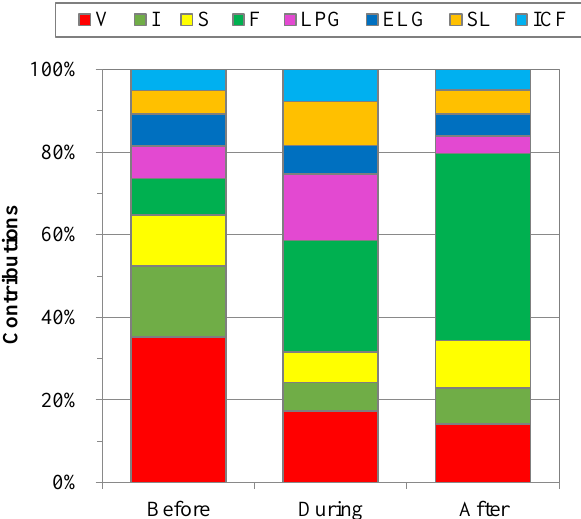
Figure 9. Overall contributions (%) for the eight sources identified by PMF analysis before, during, and after the control period during the APEC China 2014. “V” stands for vehicular exhaust; “I” stands for Industrial manufacturing; “S” stands for Solvent utilization; “F” stands for fuel combustion; “LPG” stands for liquid petroleum gas; “ELG” stands for evaporated or liquid gasoline; “SL” stands for sec- ondary and long-lived species; “ICF” stands for industrial chemical feedstock.